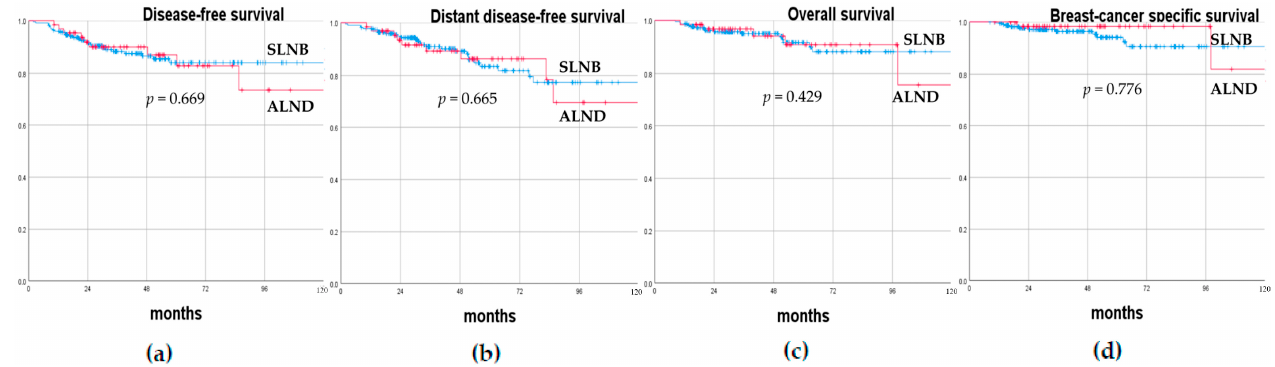
Figure 2. ( a ) Disease-free survival, ( b ) distant disease-free survival, ( c ) overall survival, ( d ) and breast-cancer-specific survival curves of breast cancer patients undergoing neo-adjuvant chemotherapy according to the type of axillary surgery performed (sentinel lymph node biopsy only versus axillary lymph node dissection).